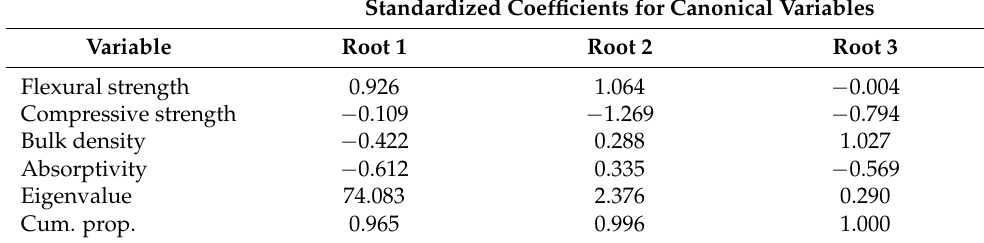
Table 6. List of coefficients of standardized canonical discriminant functions.